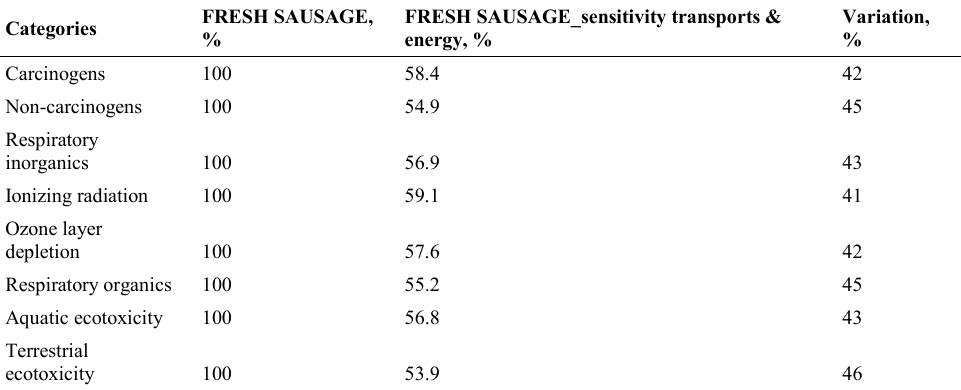
Fig. A2. Sensitivity analysis results considering a variation of transport distances and electricity consumption. T ABLE A2. S ENSITIVITY A NALYSIS R ESULTS C ONSIDERING A V ARIATION OF T